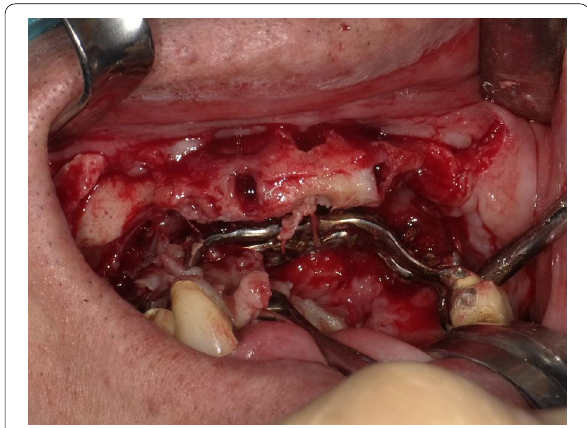
Fig. 4 Intraoperative photograph showing the subperiosteal implant being